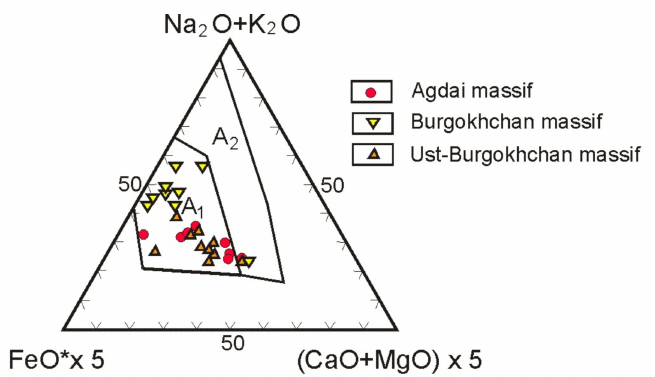
Figure 11. Ratios of molar values of petrochemical components in granites of the Selennyakh River basin. Diagram fields [58]: A 1 —granites of oceanic islands, continental rifts and hotspots formed from a basaltic source of oceanic islands, intraplate, or rift environments; A 2 —post-collisional, post-orogenic and anorogenic granites formed from a basaltic source of island arcs and continental margins, or a crustal source of tonalite and granodiorites, or by partial melting of the